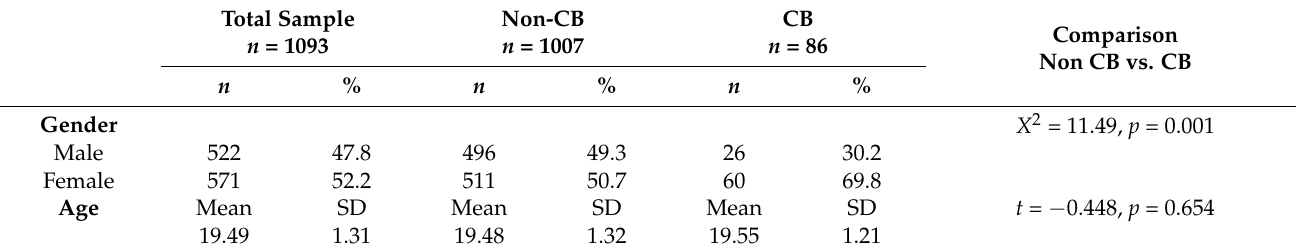
Table 1. Comparison among Non-CB and CB as for sociodemographic